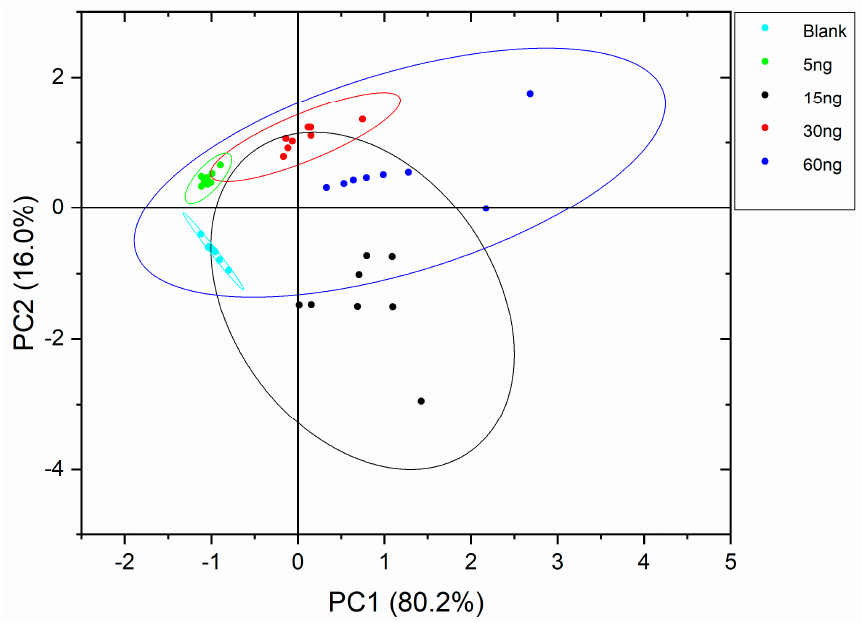
Figure 3. PCA score plot for MDMP.